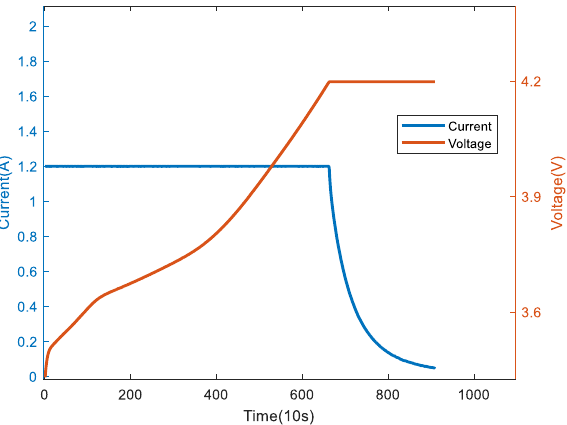
Figure 1. Constant current – constant voltage charging curve.